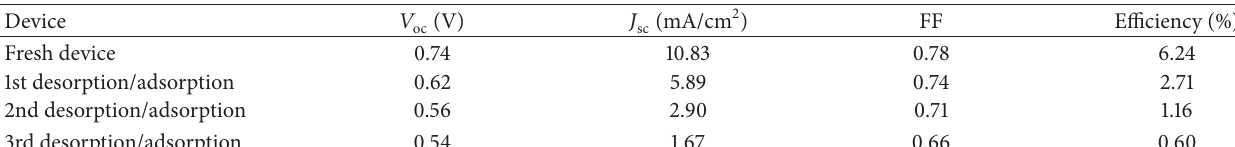
Table 3: The photovoltaic performance of DSCs under multiple adsorption/desorption processes using CH agent.